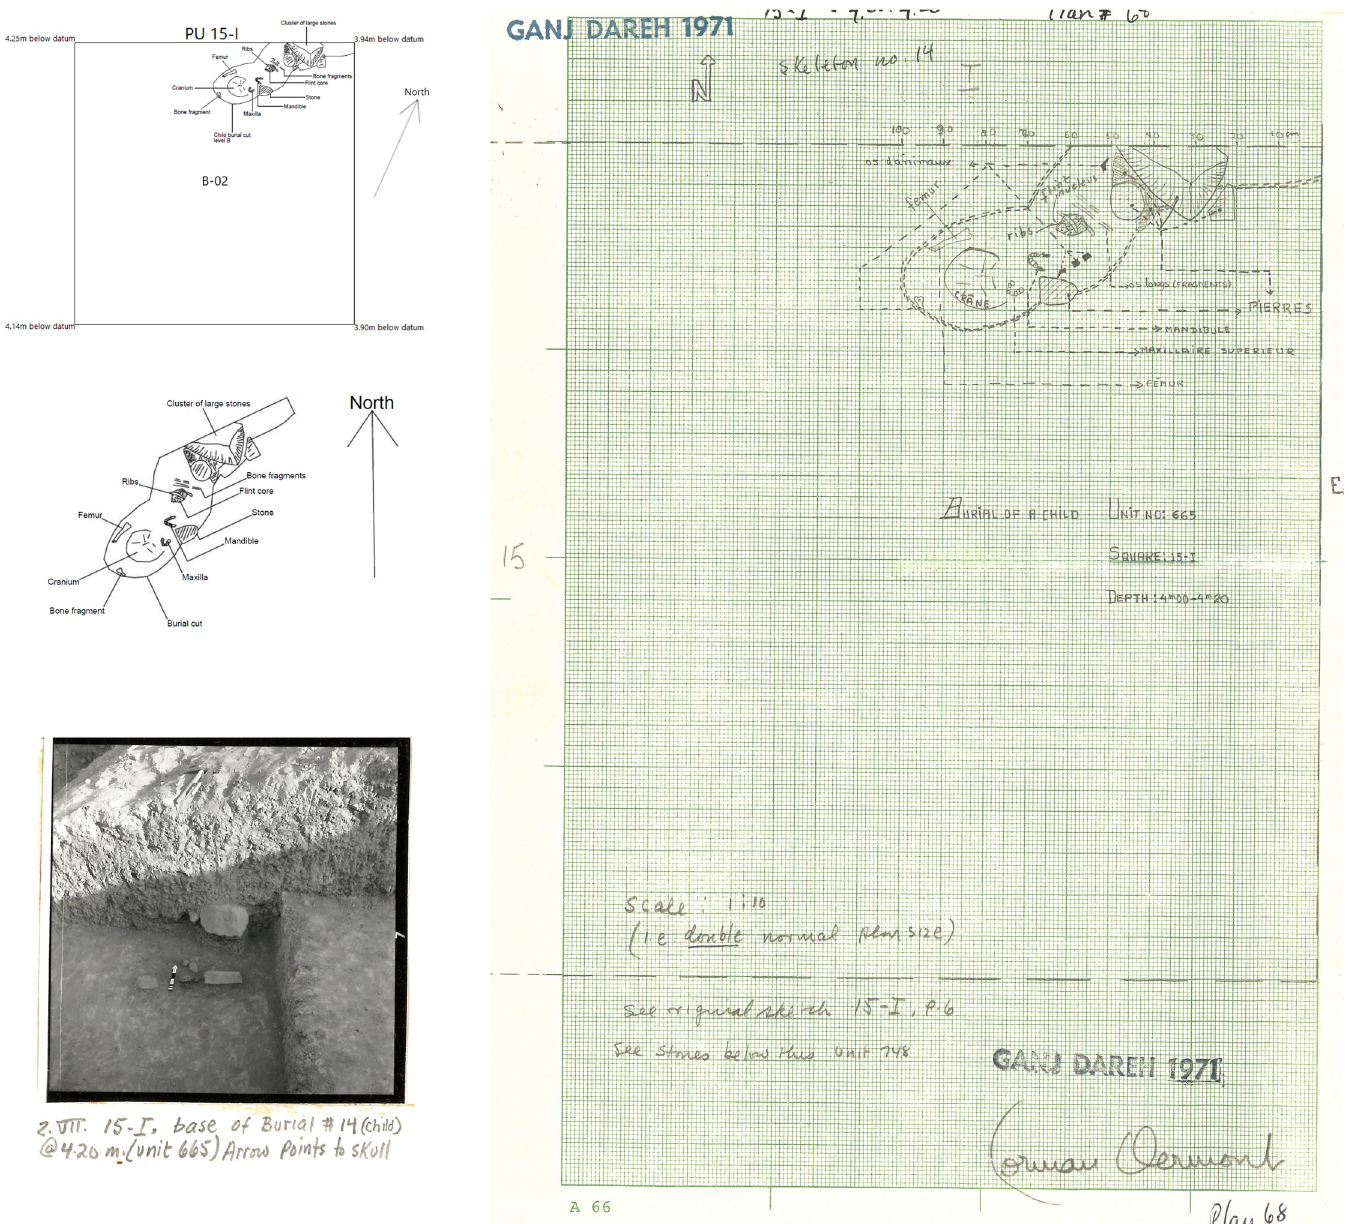
Fig 15. Child burial in level B-02. A. Position of burial in planimetric unit 15-I. B. Detail of burial. C. Archive photograph of burial. D. Field notes detailing burial.